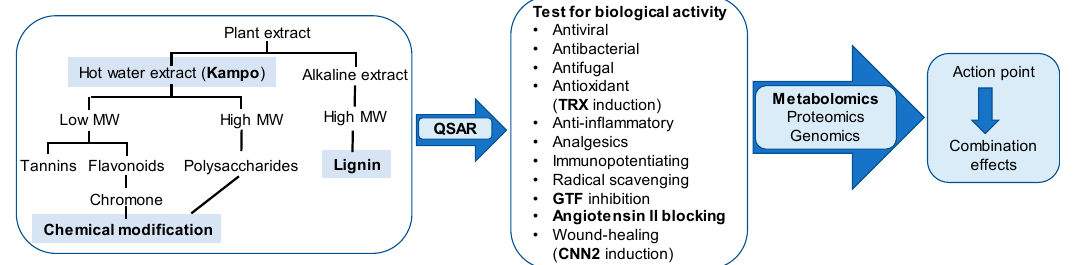
Figure 1. Flow chart to select the best combination of Kampo